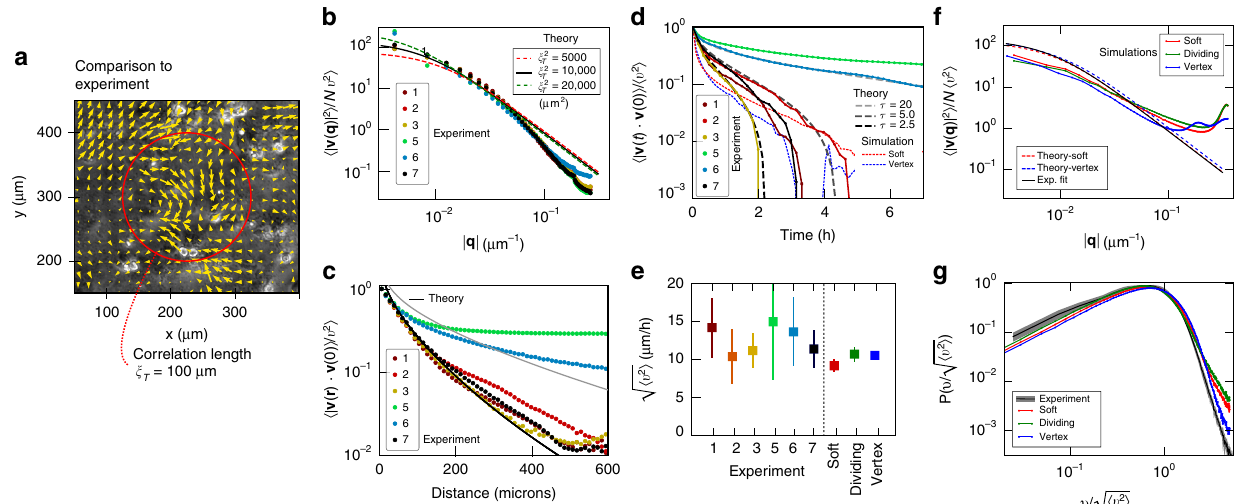
Fig. 4 Experimental results and comparison to theory and simulations. a Cell sheet image overlaid with PIV arrows, and best fi t length scale ξ T . b Experimental Fourier velocity correlation function normalised by mean velocity (dots), and best fi t to theory with a single stiffness parameter ξ 2 T ¼ μτ = ζ . c Experimental real-space velocity correlation function (dots) and theoretical prediction. d Velocity autocorrelation function for the experiments, theoretical predictions for different τ , and simulation results for the same soft disk and SPV model simulations as in f . e Mean velocity magnitude for the experiments, and the soft disk, dividing soft disk and SPV model simulations. f Numerical results for soft, soft dividing, and SPV model interactions (solid lines), and theoretical predictions (dashed lines) for the same τ = 2.5 h , k ¼ 55 μ (cid:2) 2 m h (cid:2) 1 and v 0 = 90 μ mh − 1 (see text). g Normalized velocity distribution from experiment (black with grey con fi dence interval), and the three simulated models.